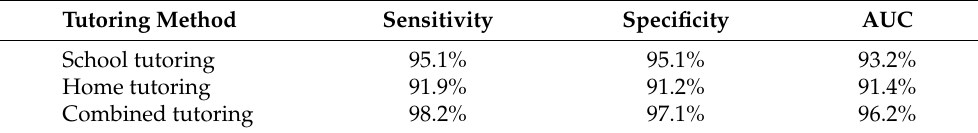
Table 3. Performance of deep SVM when used with Improved CGAN.